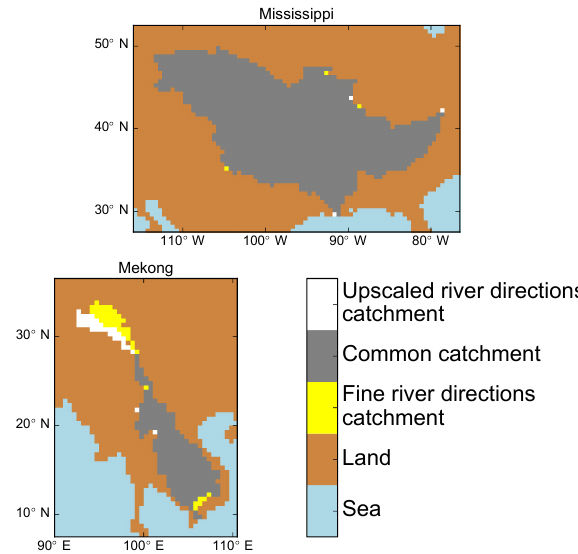
Figure 5. Comparison of the upscaled catchments of the Mississippi and Mekong on a 0 . 5 ◦ grid to the original 10min